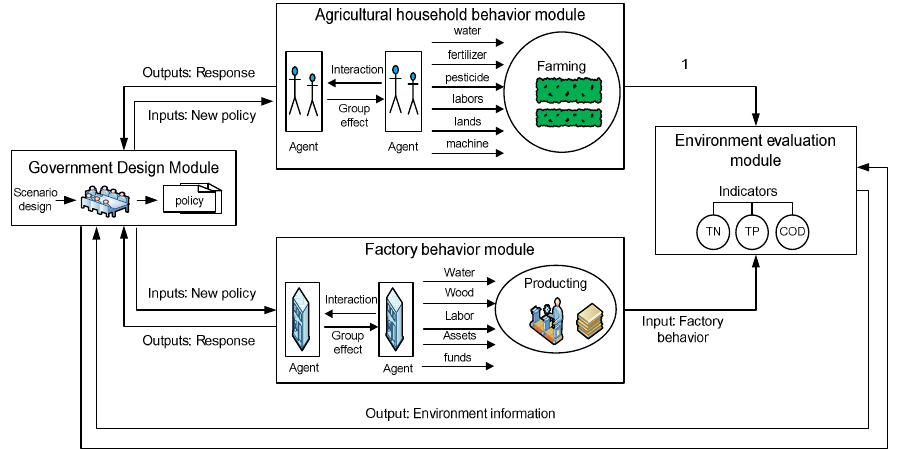
Figure 2. Framework of the agent-based model at the watershed scale.